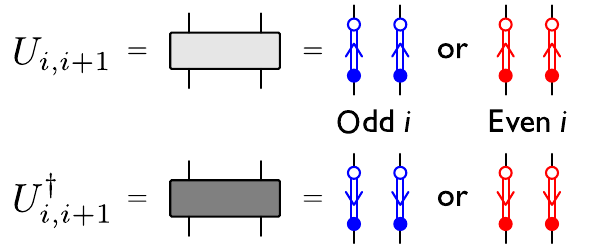
FIG. 3. Adaptations to diagrammatic notation made in order to show time evolution of an individual site. The shaded rectangles representing U i;i and U † i;i are replaced by pairs of double þ 1 þ 1 lines, with an arrow directed from the column label to the row label of the matrix. To record the distinction between odd and even i , the double lines are blue in the first case and red in the second. This color convention allows us to represent single-site diagrams without ambiguities (see, e.g., Fig. 7).